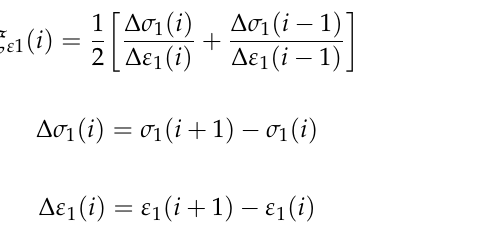
Figure 7. Drop Percentage in peak strength of intact specimens with water pressure, T-shaped fracture specimens compared to intact specimens without water pressure.